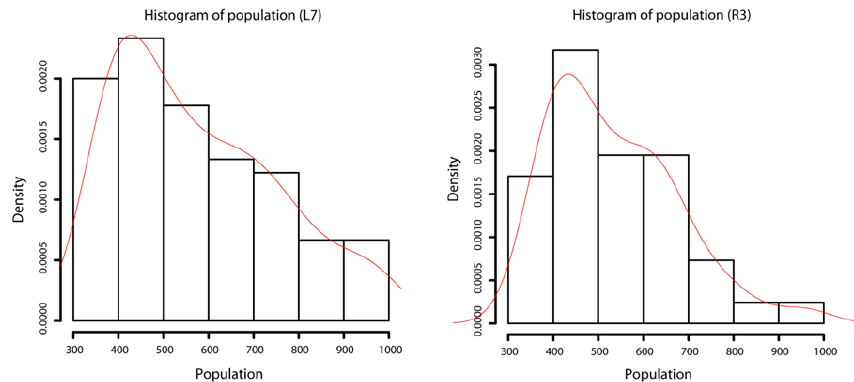
Figure 7. Examples for probability density function using R-statistics software.